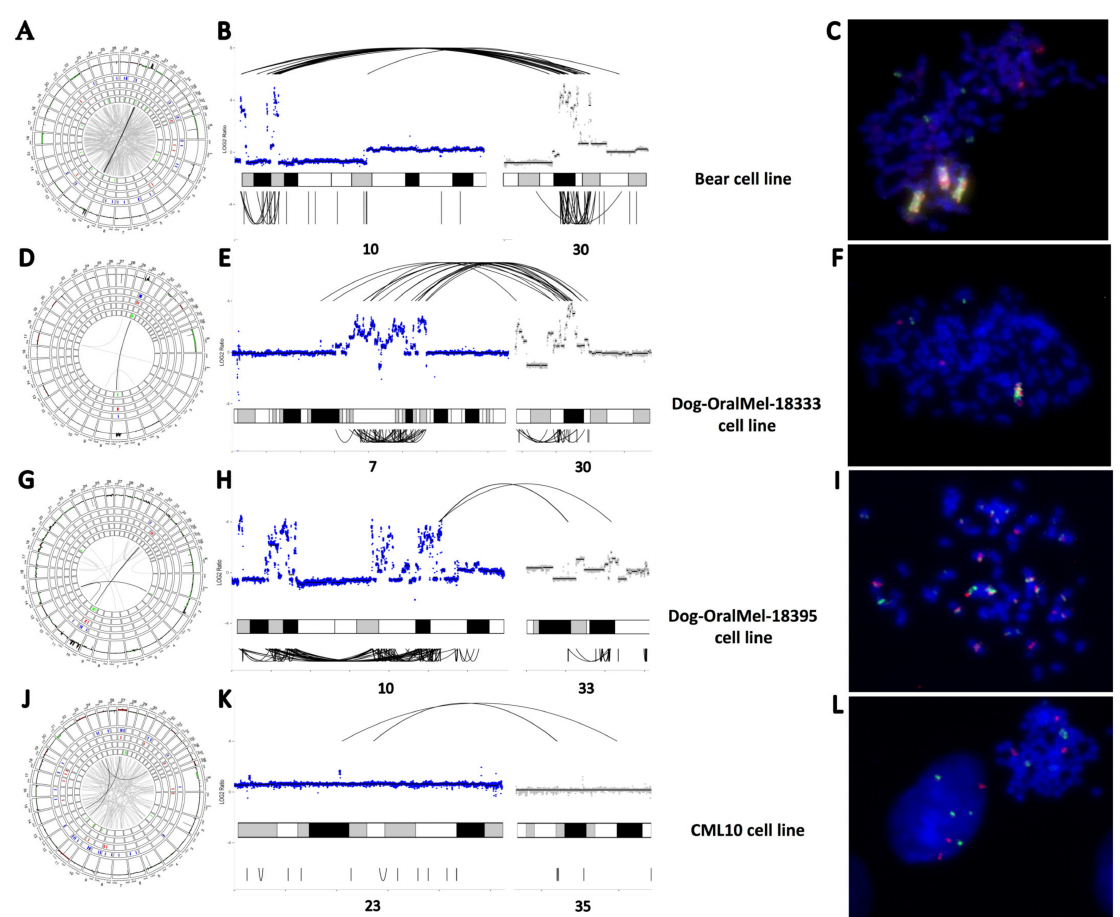
Figure 2. Structural variants (SVs) of the four canine MM cell lines. ( A – C ) SVs identified through WGS in the cell line Bear. ( A ). Circos plot representing the distribution of SVs along dog chromosomes with, from external to internal layers, CNA gains/losses (in dark red/green), deletions, duplications, insertions, and inversions in blue, light red, orange, and green, respectively. Interchromosomal break-ends (BND) are represented by gray lines connecting chromosomes with a color intensity corresponding to the number of reads validating the SV. ( B ). Focus on CFA 10 and CFA 30 present the focal amplifications and clusters of SVs (BND and INV). Copy numbers in log2ratio are represented as inter (top) and intra-chromosomal (bottom) SVs. ( C ). Fluorescence in situ hybridization (FISH) analysis of Bear cell line targeting CFA 10 (MDM2 region) and CFA 30 (TRPM7 region) in green and red, respectively, showing derivative chromosomes compatible with a chromothripsis-like event. ( D – F ). SVs of the cell line Dog-OralMel-18333. ( D ). Circos plot representing CNV, BND, DEL, and INV across the genome. ( E ). Focus on CFA 7 and CFA 30 presenting the focal amplifications and cluster of SVs (BND, DEL, DUP and INV). ( F ). FISH analysis of Dog-OralMel-18333 cell line targeting CFA 7 and CFA 30 (TRPM7 region) in green and red, respectively, showing derivative chromosomes compatible with a chromothripsis-like event. ( G – I ). SVs of the cell line Dog-OralMel-18395. ( G ). Circos plot representing CNV, BND, DEL, and INV across the genome. ( H ). Focus on CFA 10 and CFA 33 presenting the focal amplifications and cluster of SVs (BND, DEL, DUP, and INV). ( I ). FISH analysis of Dog-OralMel-18395 cell line targeting CFA 10 (MDM2 region) and CFA 10 (CDK4 region) in green and red, respectively, showing derivative chromosomes compatible with a chromothripsis-like event. ( J – L ). SVs of the cell line CML10. ( J ). Circos plot representing CNV, BND, DEL, and INV across the genome. ( K ). Focus on CFA 23 and CFA 35 presenting interchromosomal rearrangement. ( L ). FISH analysis of CML10 cell line targeting CFA 10 (MDM2 region) and CFA 30 (TRPM7 region) in green and red, respectively, showing 3 to 4 spots compatible with a tetraploid state without massive genomic rearrangements. Image ( A , D , G , J ) are available in the Supplementary Material (Figures